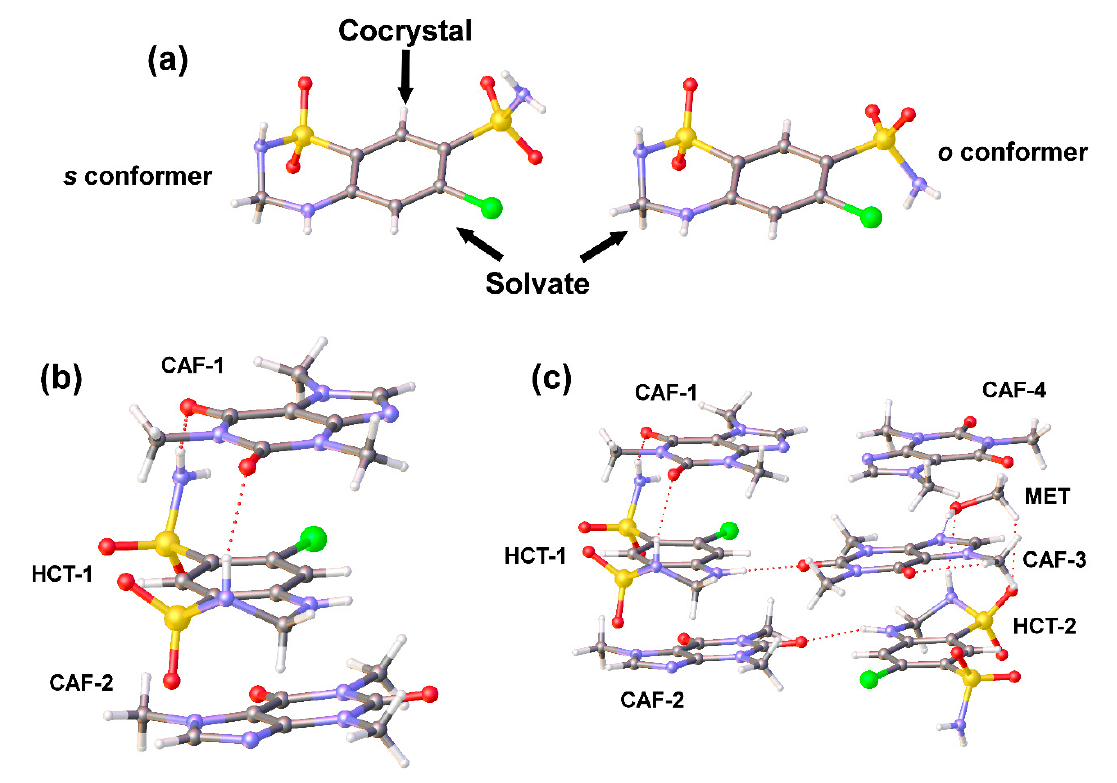
Figure 4. ( a ) Detail of the o and s HCT conformations observed in the crystal structures reported in this work; ( b ) asymmetric unit of the HCT-CAF cocrystal; ( c ) asymmetric unit of HCT − CAF ·MET.